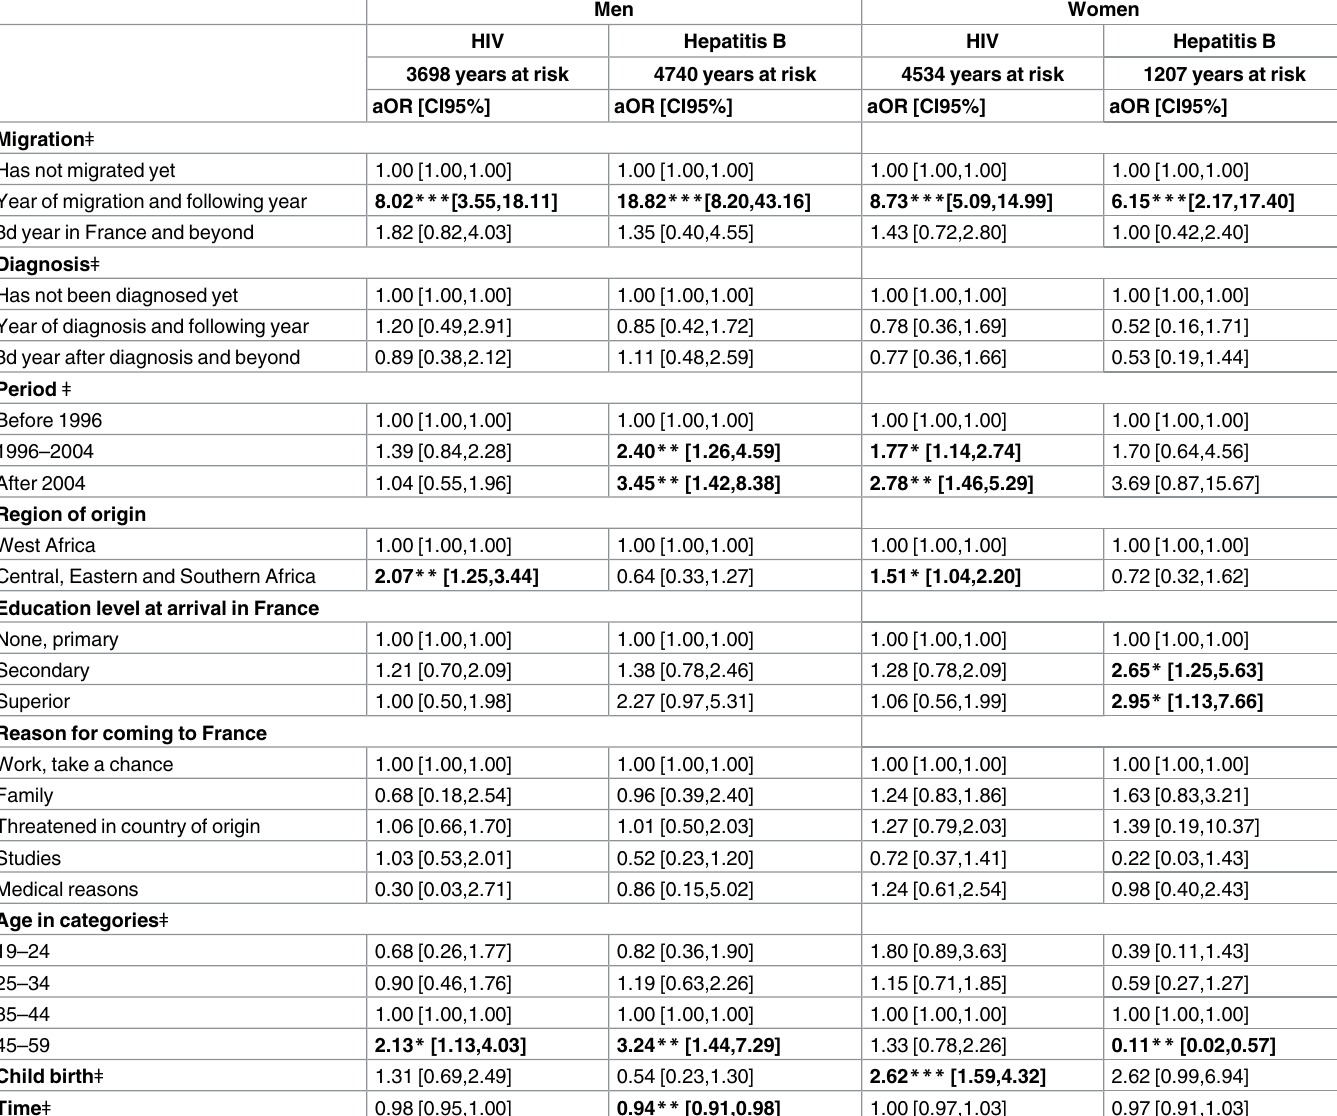
Table 2. Factors associated with transition towards inactivity year by year since 18 years of age until data